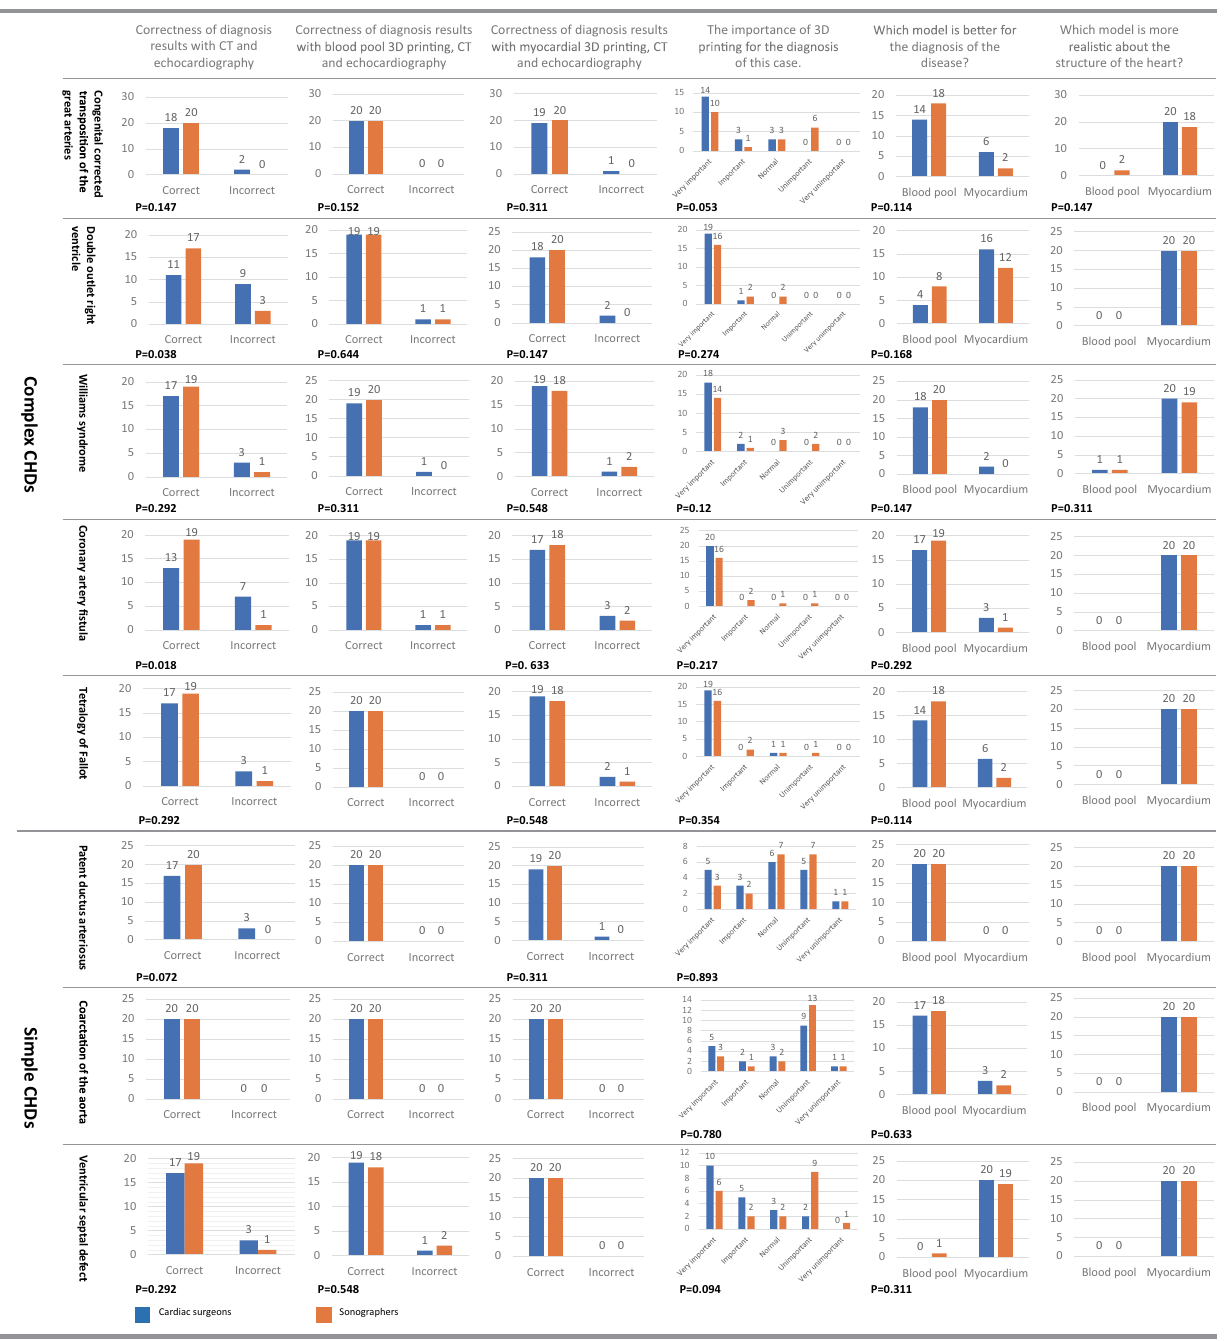
Figure 5. Subgroup analysis between experienced cardiac surgeons and sonographers. Blue represents the cardiac surgeon group, and red represents the sonographer group. The correctness of diagnosis results with CT and echocardiography, with blood pool 3D prints and echocardiography, and with myocardial 3D prints and echocardiography showed the difference of accuracy under three different diagnostic methods, it showed that 3D printing improved the diagnosis slightly. In the survey about the importance of 3D printing, the cardiac surgeons think more than sonographers that 3D printing is important for the diagnosis of CHDs. The importance of 3D printing for the diagnosis of each case showed the demand for 3D printing at different levels, which showed a difference between complex CHDs and simple CHDs. In the survey of which model is better for the diagnosis of the disease, the cardiac surgeon group showed a preference for myocardial models than the sonographer